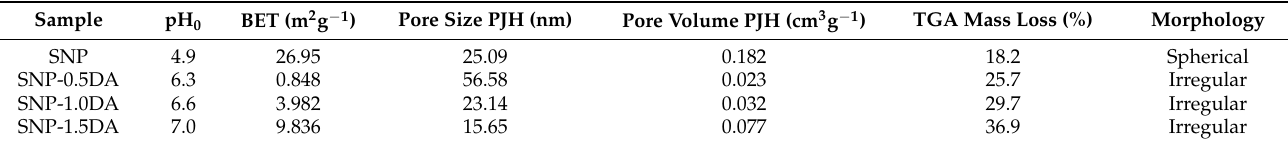
Table 2. Characteristics of the prepared nanocomposites.